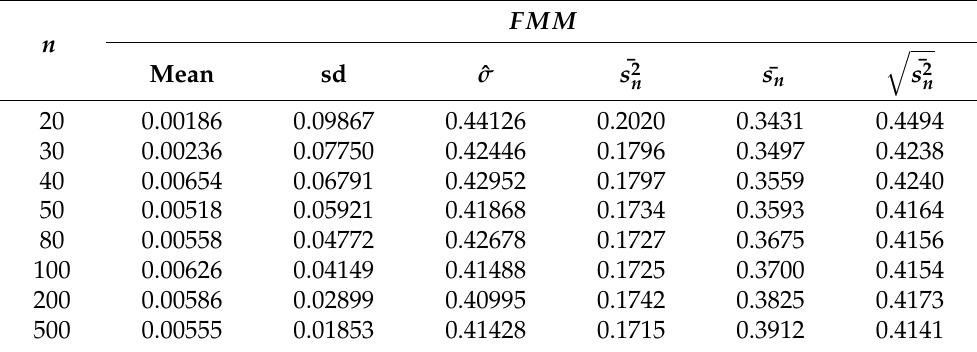
Table 5. Mean, standard error of the mean, estimated standard deviation of the population, mean of variances, mean of standard deviations and square root of the mean of variances for each simulated sample size n (based on 5000 iterations).